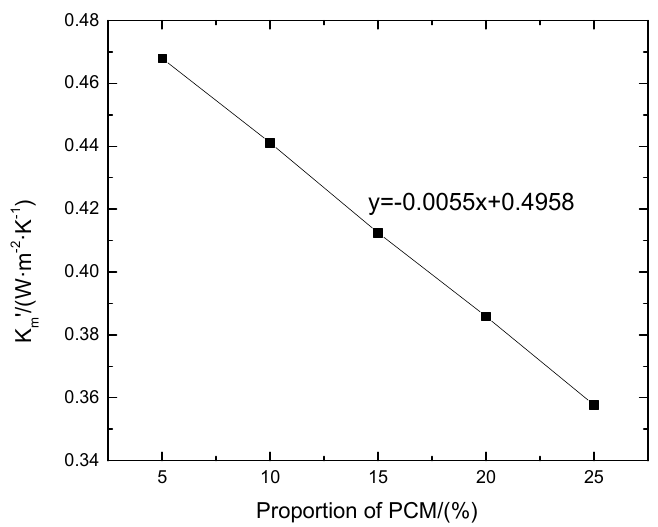
Figure 19. Heat transfer coe ffi cient—phase diagram of the low temperature phase change